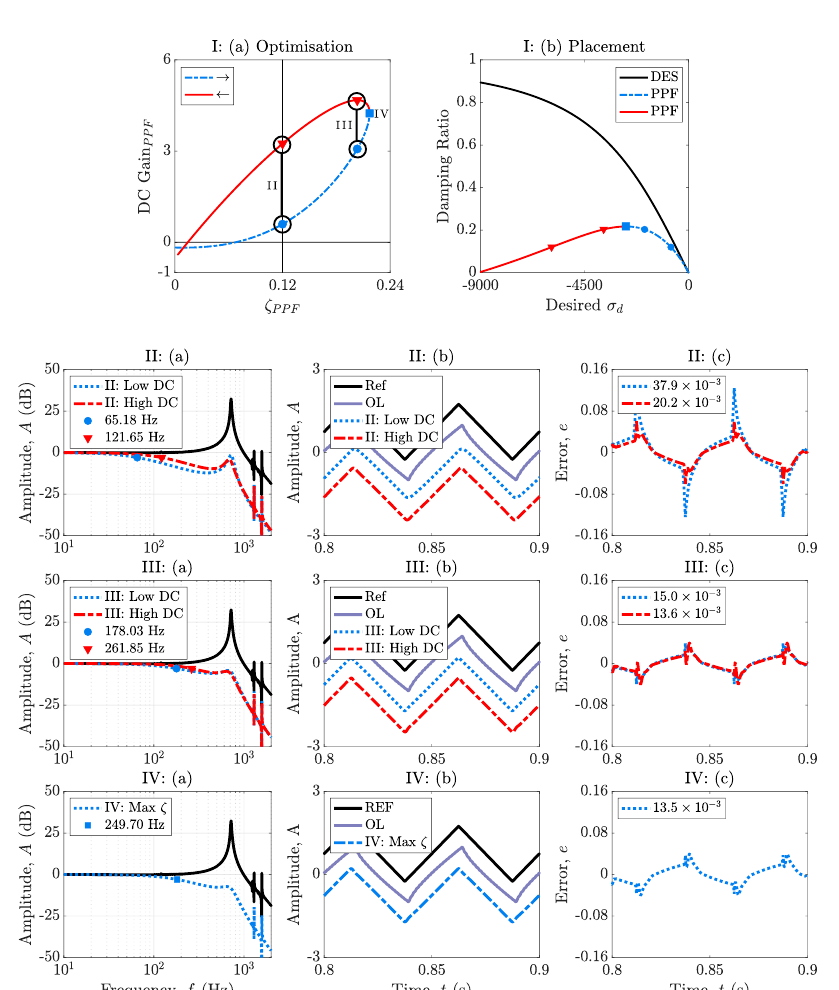
Figure 3. The PPF optimisation curve, shown by I : ( a ), in the middle acts as the center figure for the simulation sets ( II – IV ). I : ( b ) shows the desired pole location versus damping ratio for the PPF con- troller. Simulation sets ( II – III ) correspond to the closed–loop damping values of ζ PPF = [ 0.12,0.2034 ] , respectively, and then at each point, the PPF controlled system is put in a closed–loop with an integral tracker. For each set of simulations, the damped and tracked bode plot, triangle wave time history and error plots are considered for each possible plot on the solid and dashed sections of the optimisation curve. I : ( a , b ) represent the PPF optimisation curve and the desired and PPF pole–placement curves respectively. Key points are marked on I : ( a ) at ζ PPF = [ 0.12,0.2034,0.217 ] . Sub figures ( II – IV ): ( a – c ) consist of each Bode responses, time histories and error plots